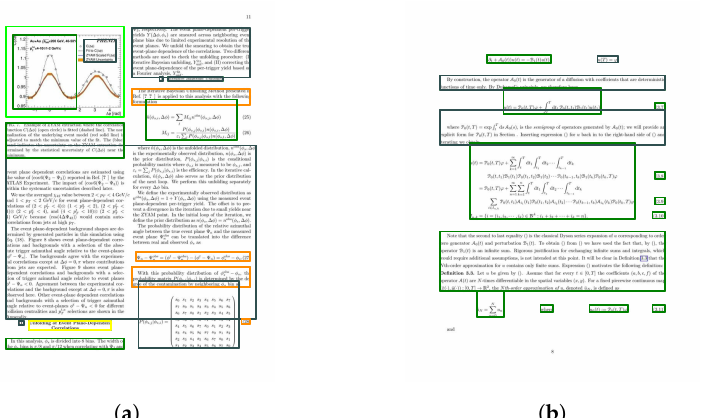
Figure 6. Samples chosen from the DocBank [19] dataset show that few annotations are wrongly classified or nested annotations exist. ( a ) The existence of too many nested annotations in the ground- truth, which can negatively impact the model’s prediction power. ( b ) The anomalies present in the annotations, such as equation numbers (dark-green color) marked as equations, causing the model to